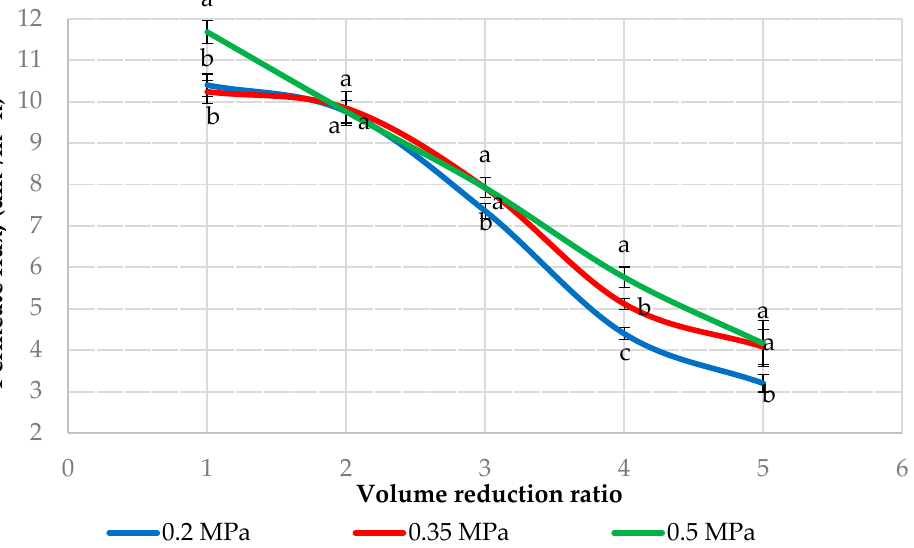
Figure 1. Effect of volume reduction ratio on the permeation flux during ultrafiltration of sweet buttermilk. Different lowercase letters (a, b, c) show a significant difference between the permeate flux at 0.2, 0.35, and 0.5 MPa ( p < 0.05).